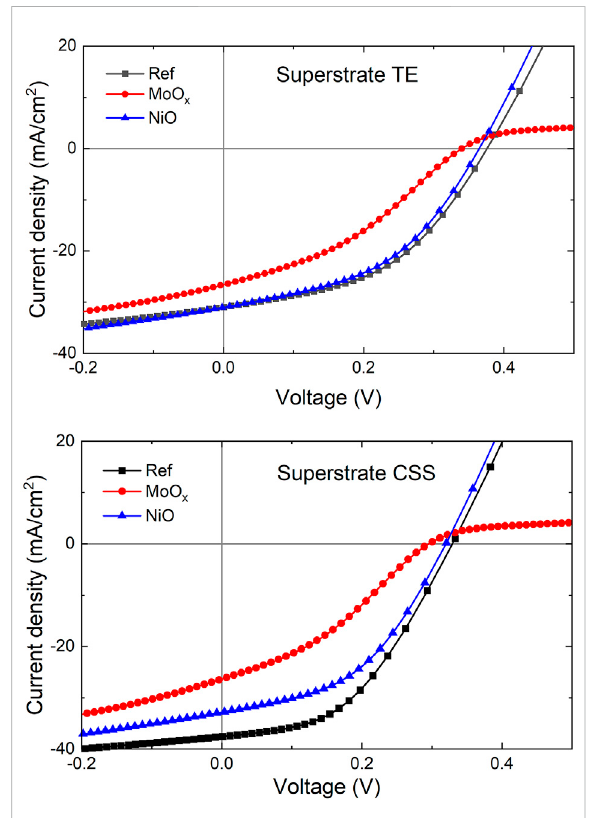
FIGURE 15 J-V curves for simulated TE and CSS Sb HTLsinsuperstratecon fi guration.Roll-overbehaviourisevidentin both TE and CSS devices with MoO x HTL indicating a carrier transport barrier at the back